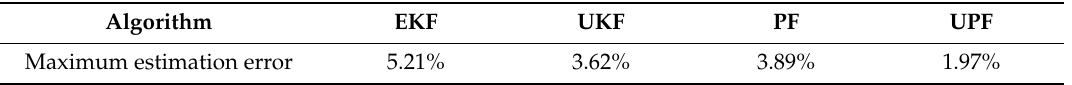
Table 10. Maximum Estimation Error of Di ff erent Methods at 25 ◦